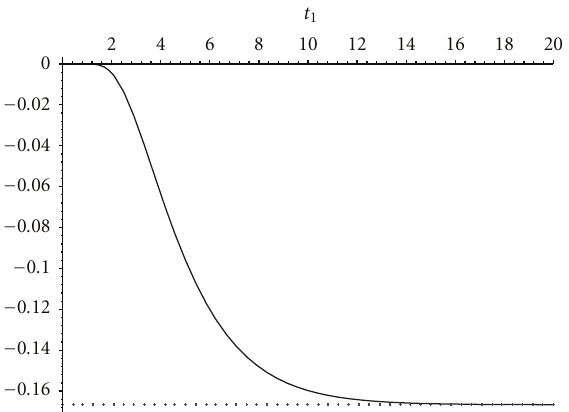
= − 1 / 6 (dotted line) and u ∗ 1 =∞